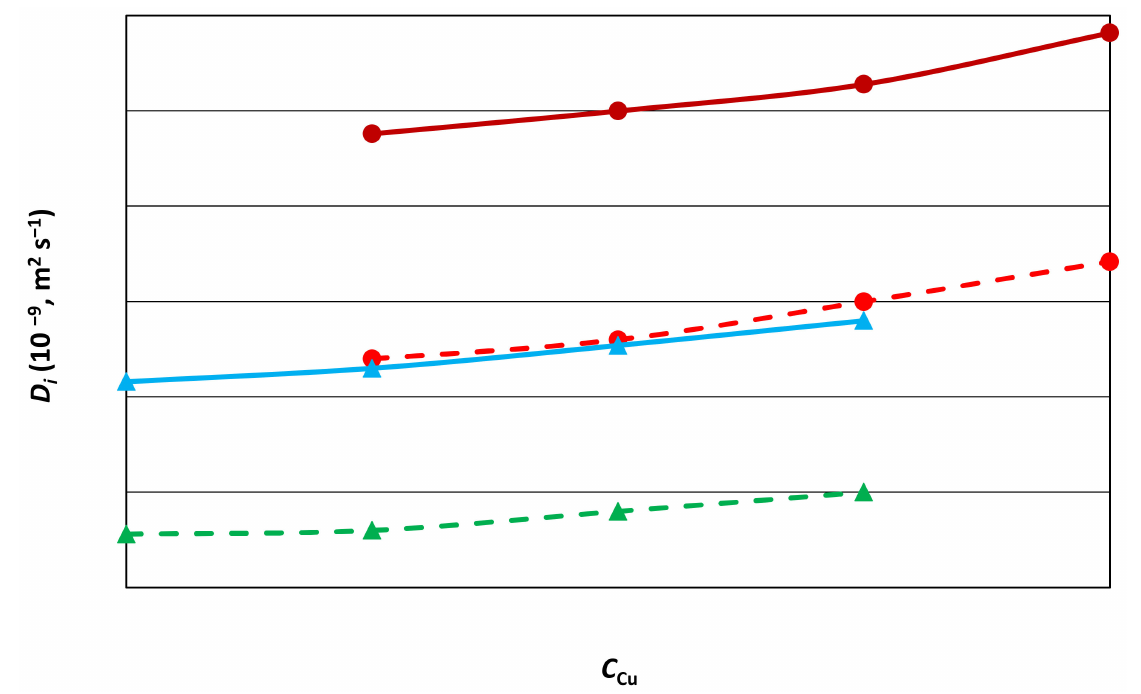
Figure 2. Self-diffusion coefficients of Cu (circles) and Au (triangles) in liquid Cu-Au alloy at T = 1423 K (dashed line) and T = 1573 K (solid line).